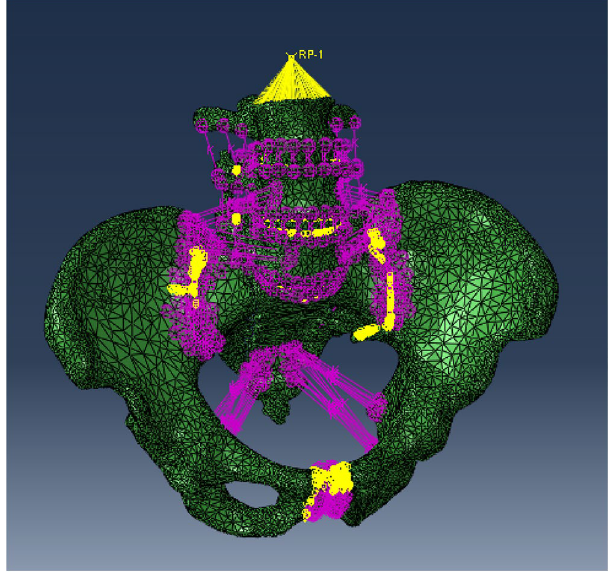
Figure 3. Finite element model after material assignment and ligament